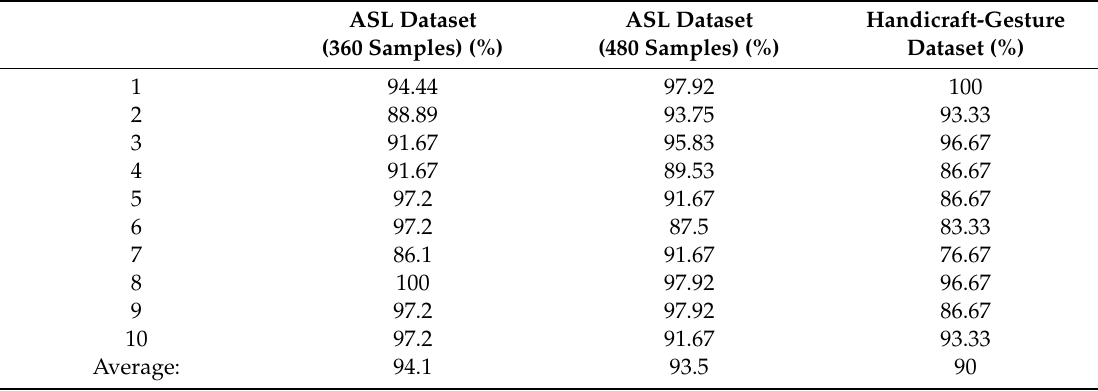
Table 4. Recognition accuracies (%) for the three datasets by using the 10-fold cross-validation method.